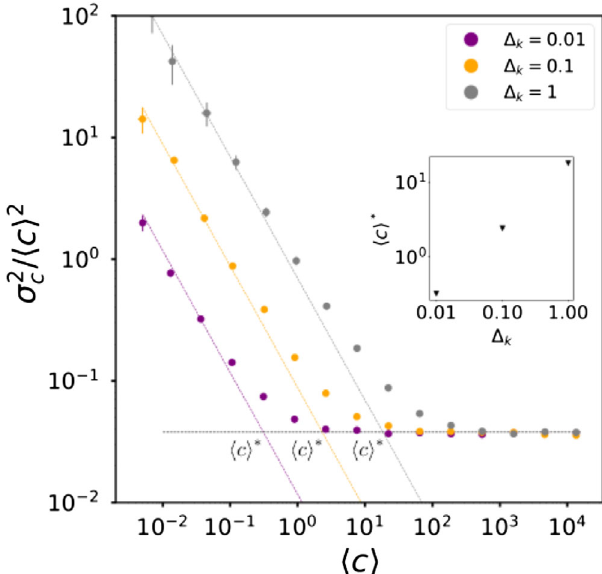
FIG. 7. A as a function of h c i when K is generated from a n ¯ K Gamma distribution with mean value and variance n ¯ K σ 2 , for three values of Δ . The mean value h c i is ¼ Δ k n k k ¯ K . The error bars are obtained by running changed by changing n the simulations for five realizations and calculating the resulting standard